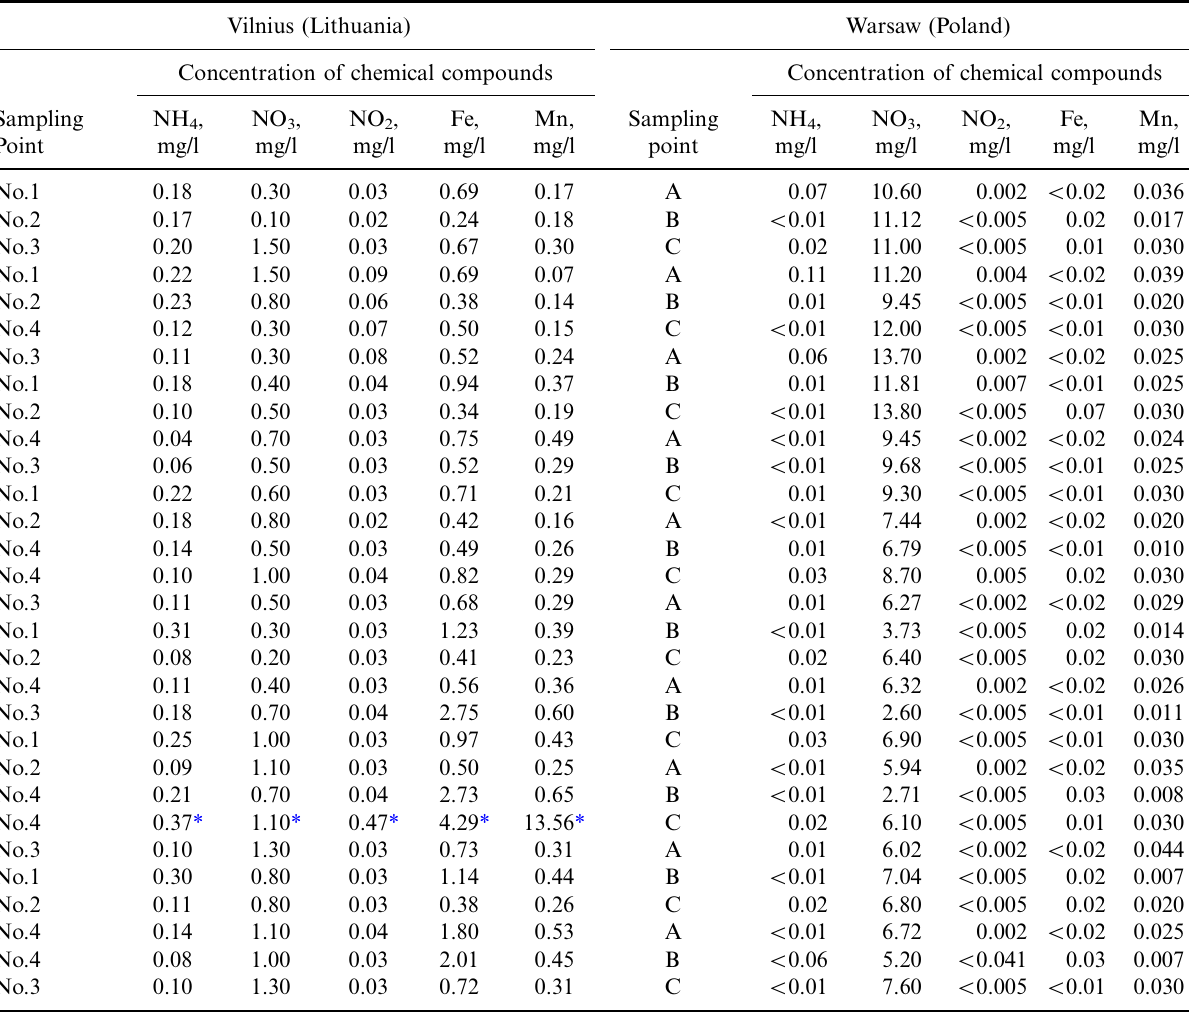
Table 2. The results of water quality at the characteristic point in the pipeline of water supply systems Vilnius